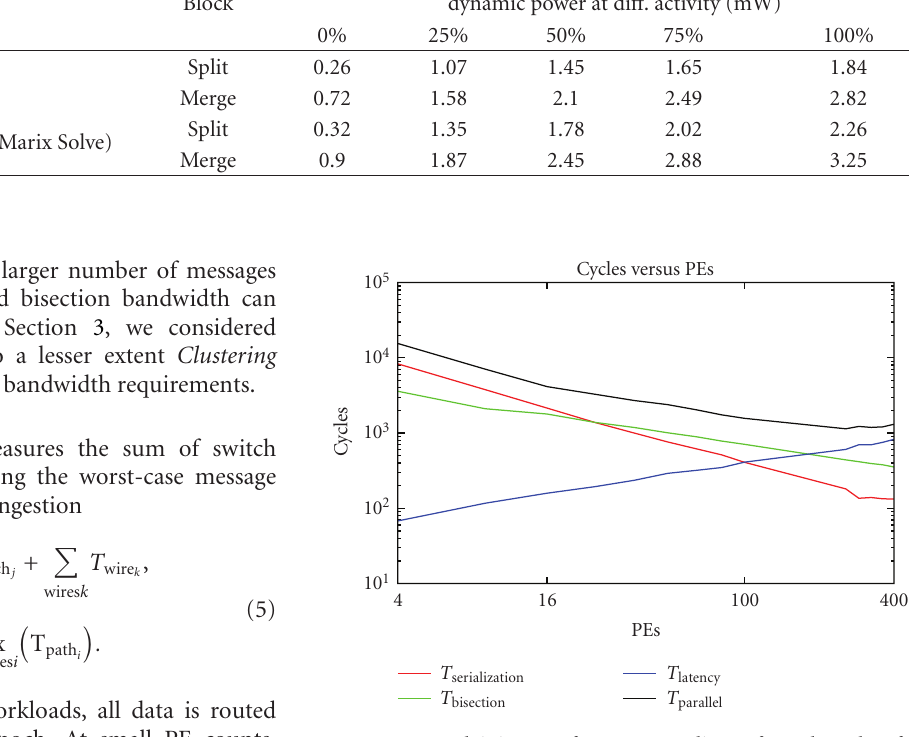
Figure 9: Explaining performance scaling of total cycles for bcsstk11